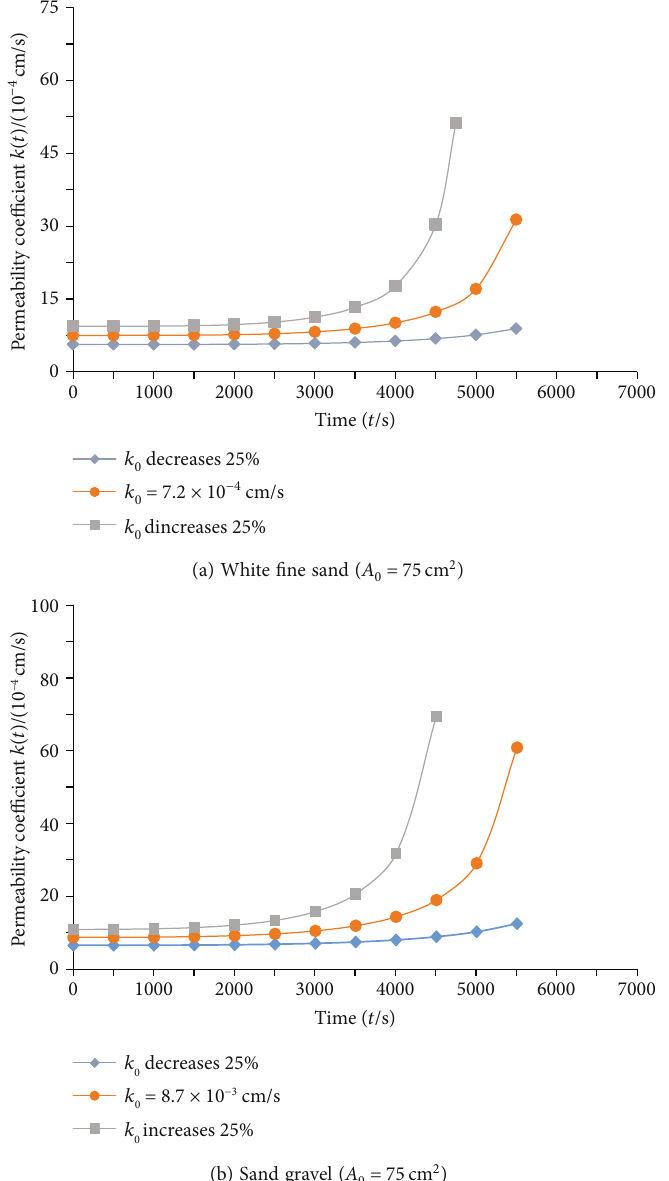
Figure 5: Variation curve between permeability coe ffi cient and time at the free surface of soil with di ff erent k